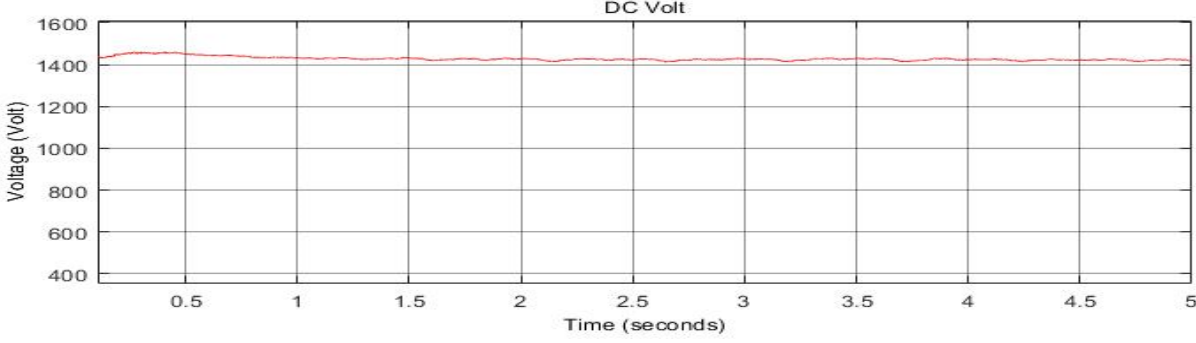
Figure 15. DC source voltage.